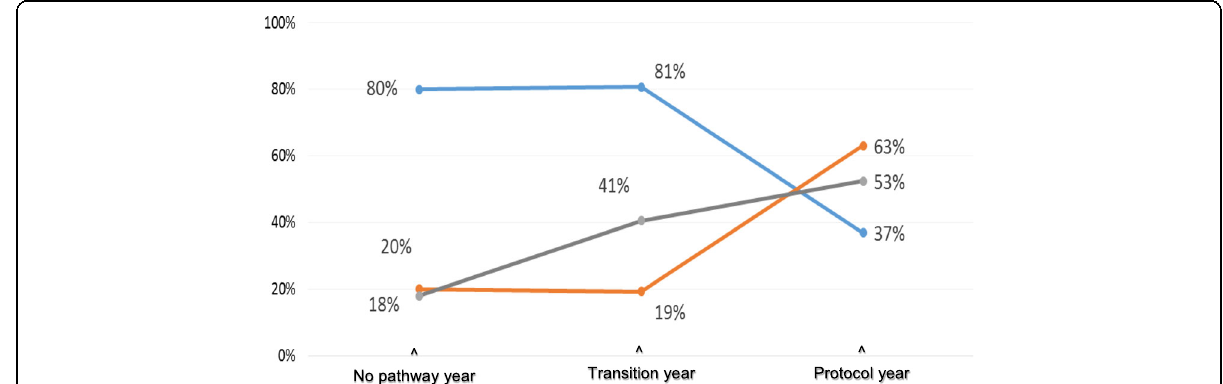
Fig. 5 CT and ultrasound utilization rates for all